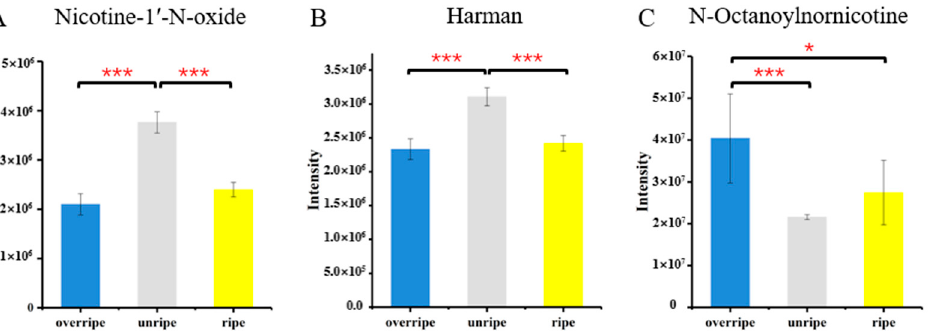
Figure 11. The differential alkaloids between different maturity grades. ( A ) Nicotine-1 ′ -N-oxide; ( B ) Harman; ( C ) N-Octanoylnornicotine, in the methanol extracts of the flue-cured NTL leaves. All data represent the mean values ± standard errors. The asterisks represent significant differences. One asterisk 0.05 ≧ p > 0.01, two asterisks 0.01 ≧ p > 0.001, three asterisks p ≧ 0.001.